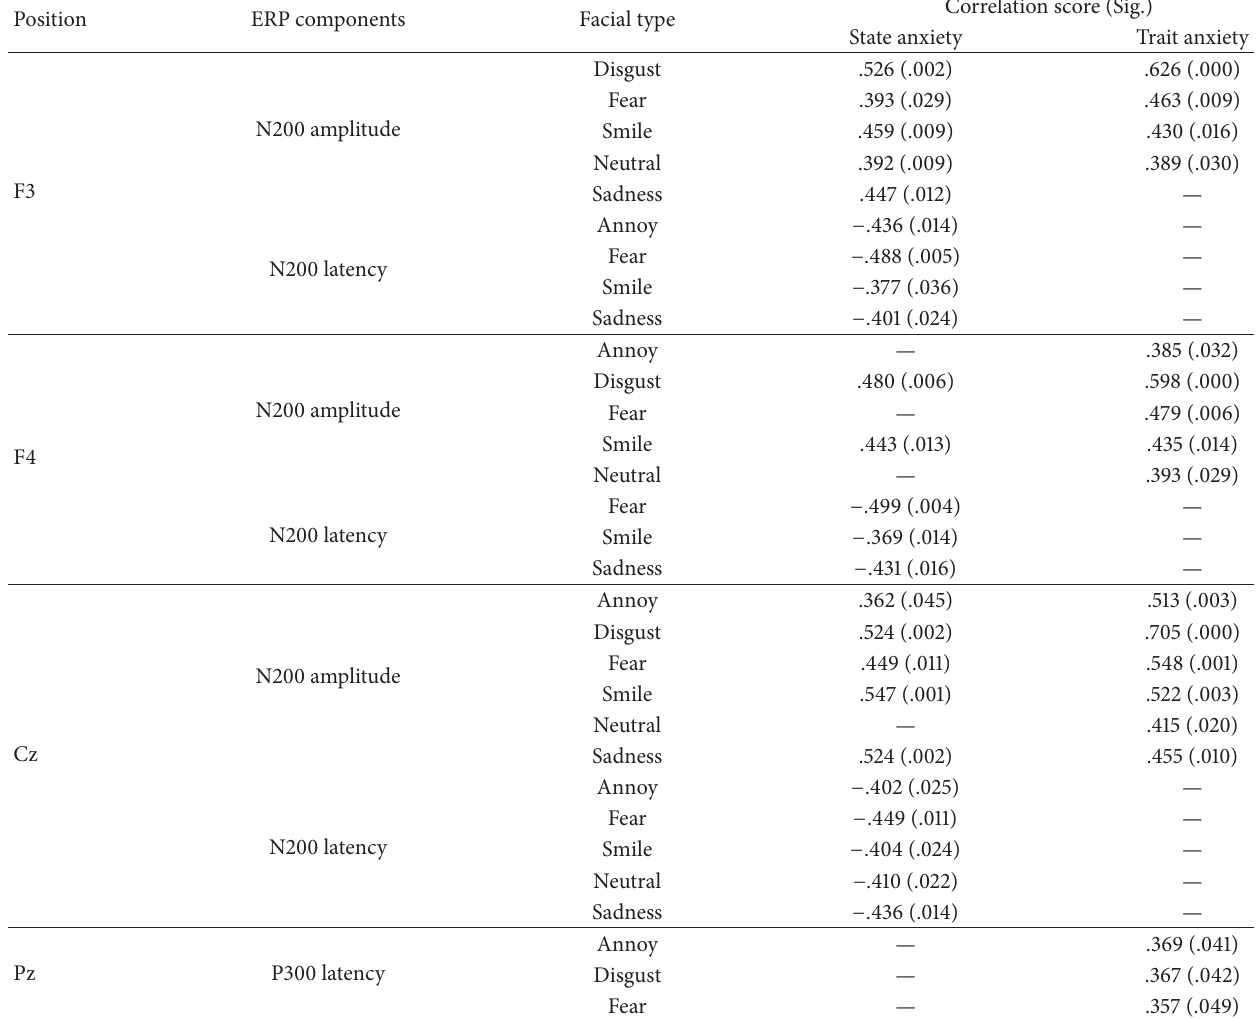
Table 1: Correlation scores among ERP components and